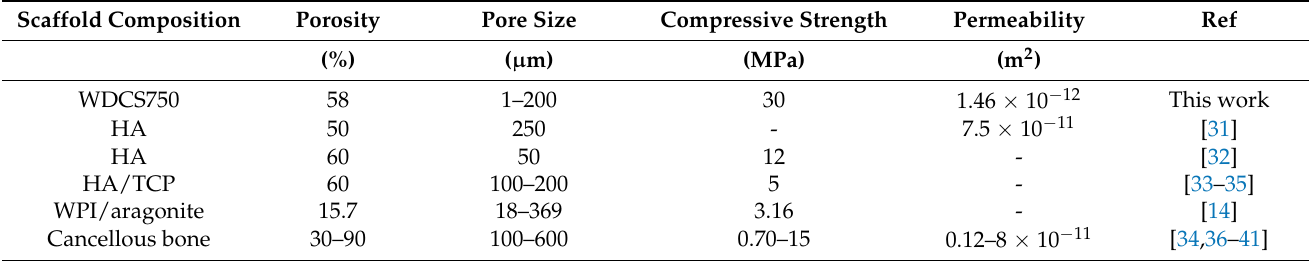
Table 5. Comparison between different bone scaffolds with similar